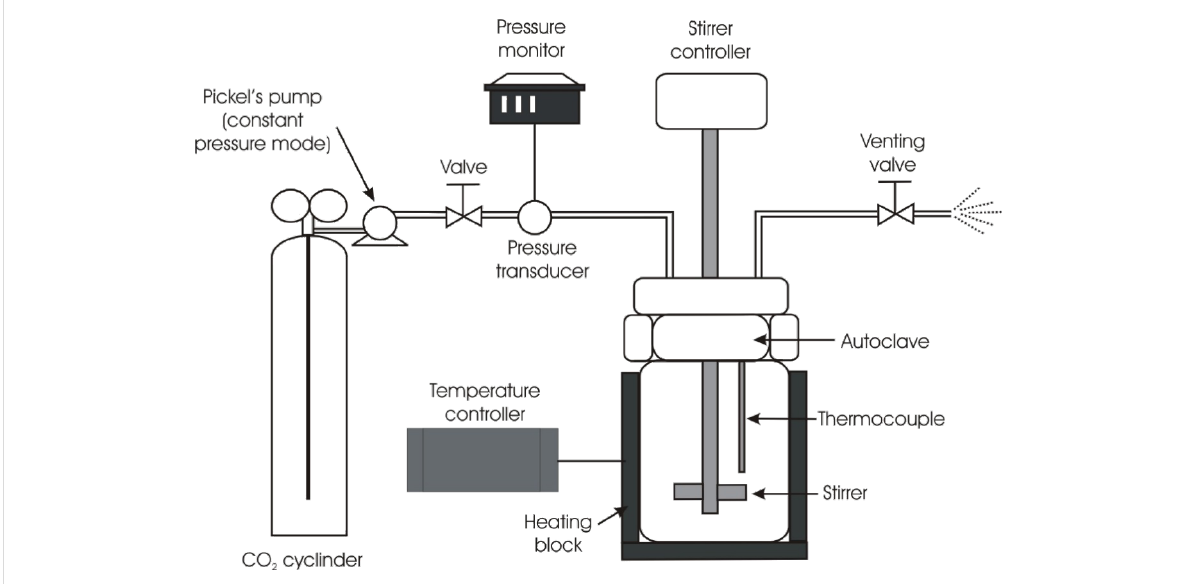
Figure 1: Schematic diagram of the stirred autoclave reactor. Pickel’s pump NWA PM101 was used to achieve supercritical pressure.